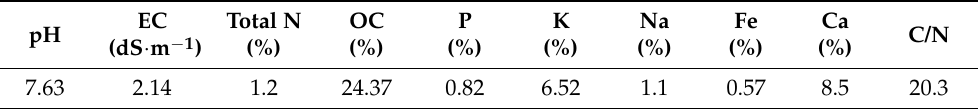
Table 1. Initial vermicompost